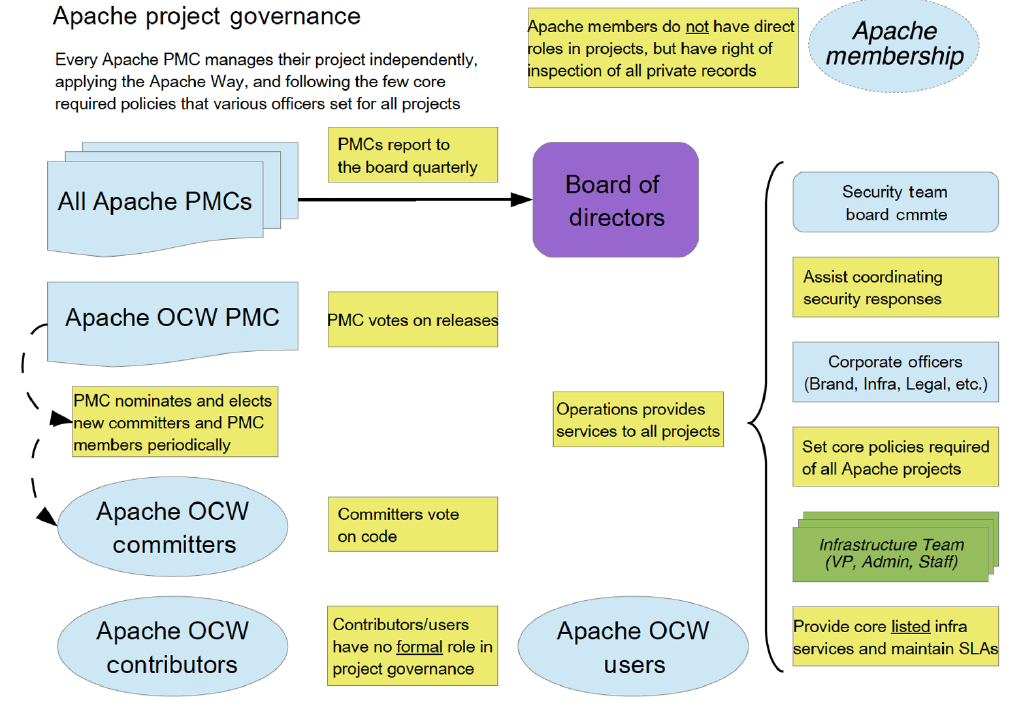
Figure 6. Schematic representation of Apache OCW project governance.